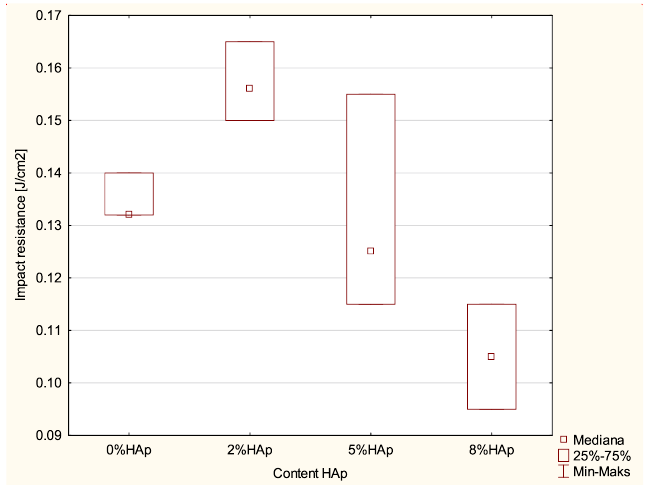
Figure 4. Statistically significant differences in impact resistance among examined groups.